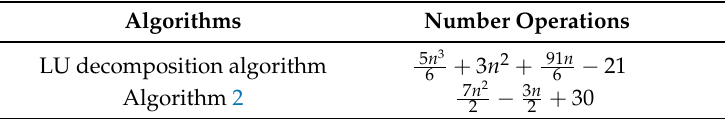
Table 2. Comparison of the total number operations for inverse of A